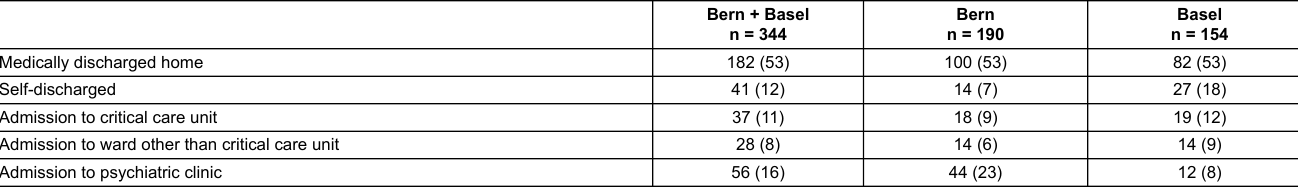
Table 4: Discharge data in Bern and Basel, n